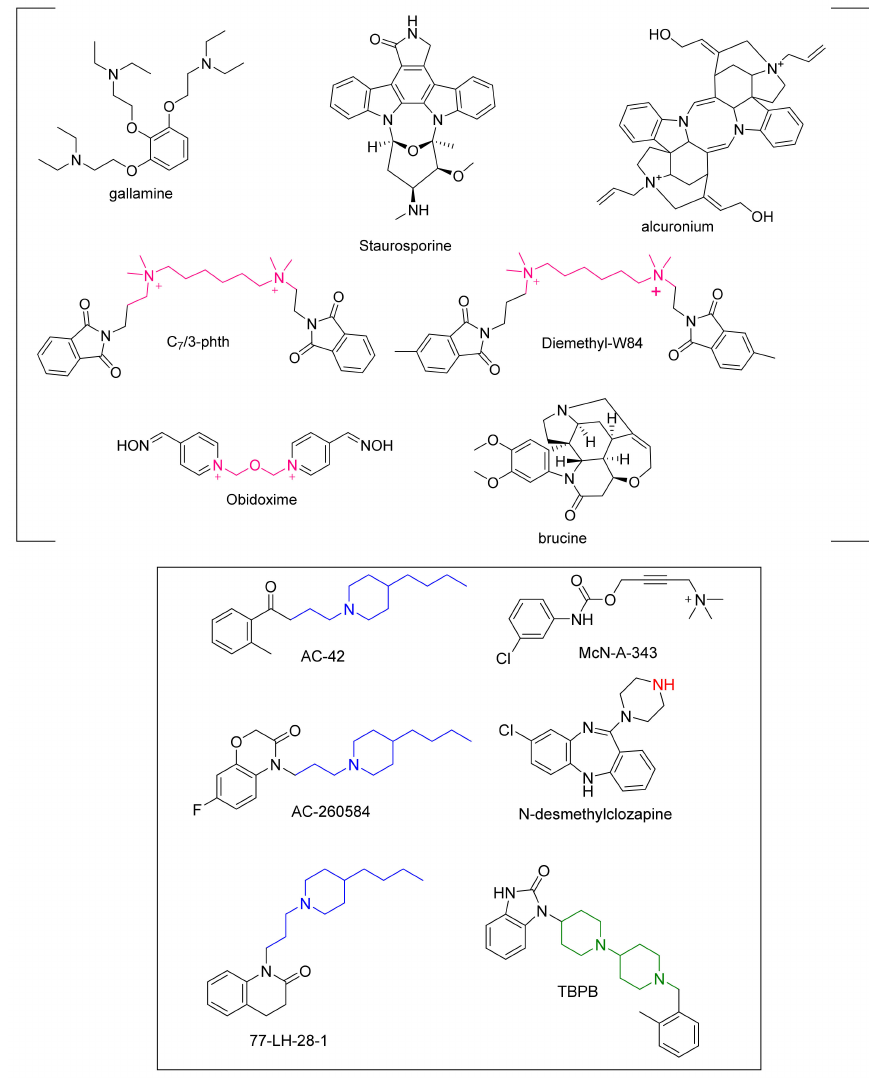
Figure 3. Neuromuscular blocking agents and bis-quaternary ammonium compounds (brackets). First generation of allosteric modulators